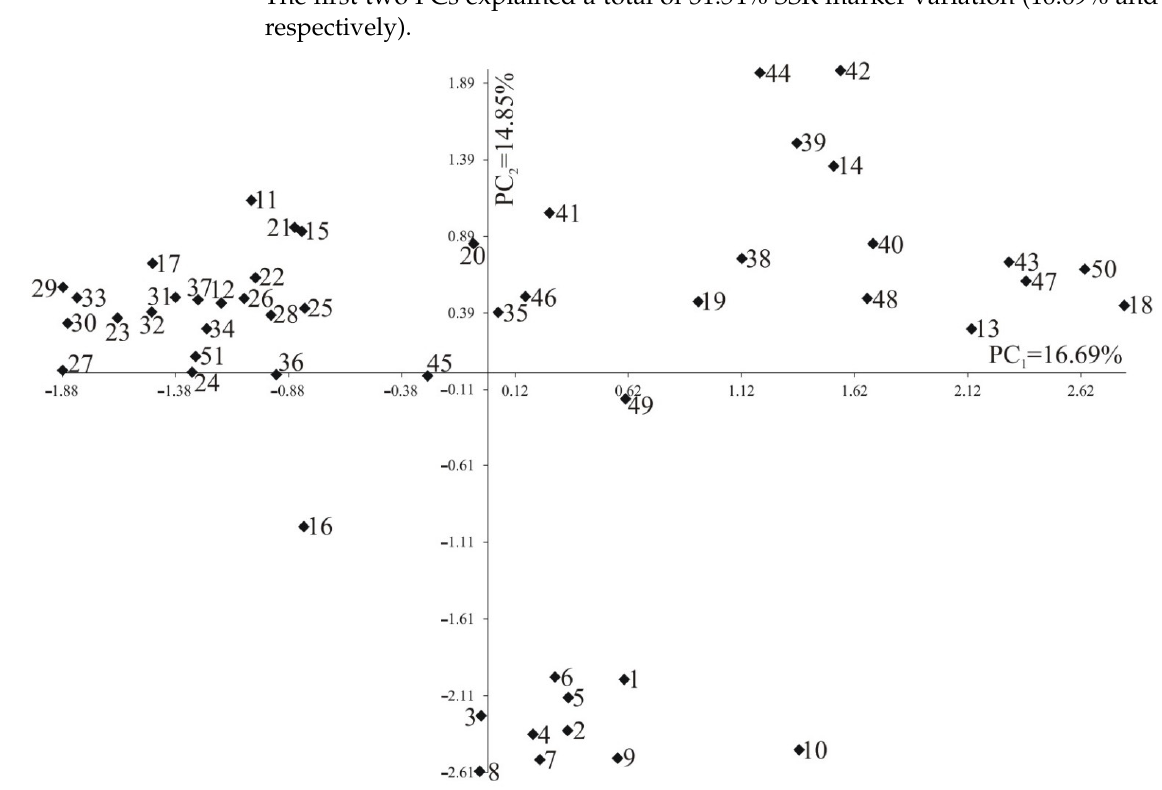
Table 5. Results of blackleg field resistance assessment for hybrid plants. The level of infestation is expressed as a percentage.